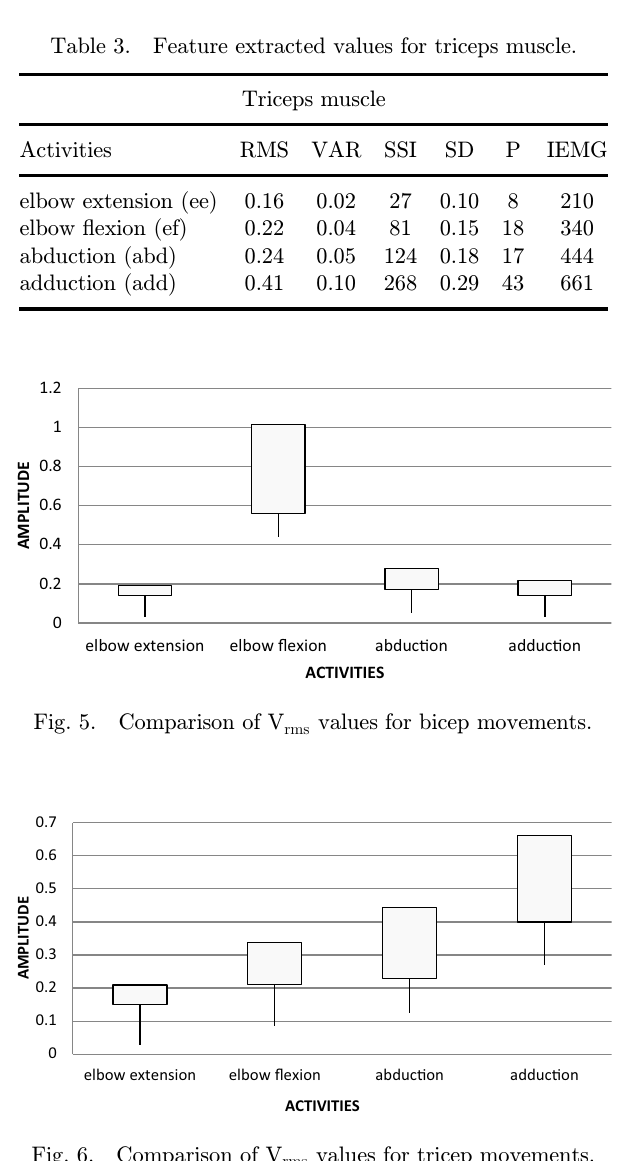
Fig. 6. Comparison of V rms values for tricep movements.